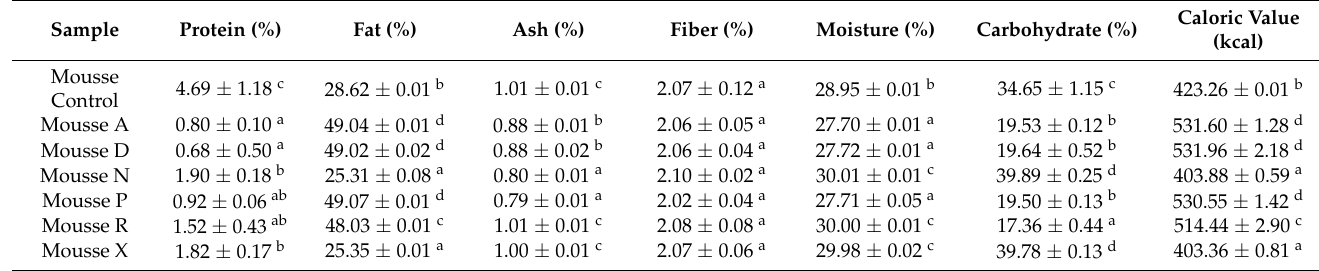
Table 9. Proximate compositions of chocolate